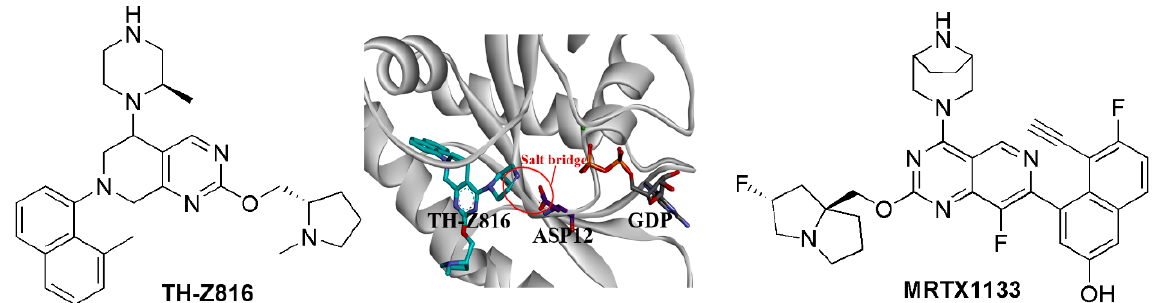
Figure 6. The salt bridge strategy for KRAS inhibitors.